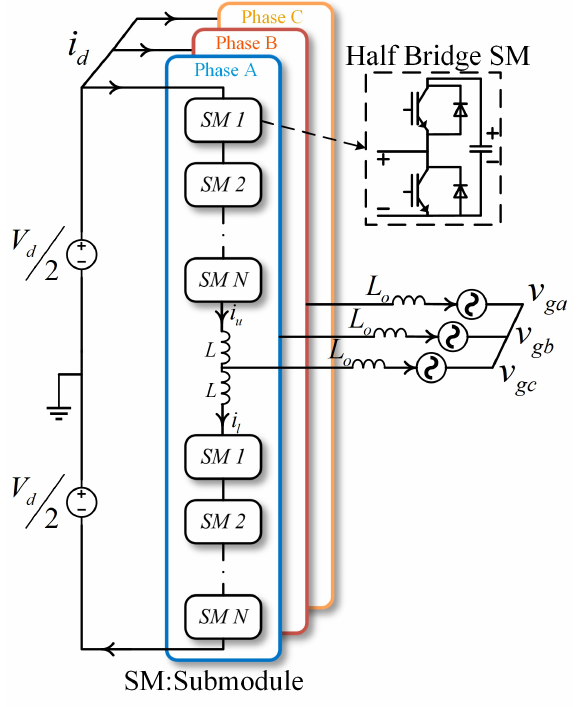
Figure 1. Modular multilevel converter (MMC) topology